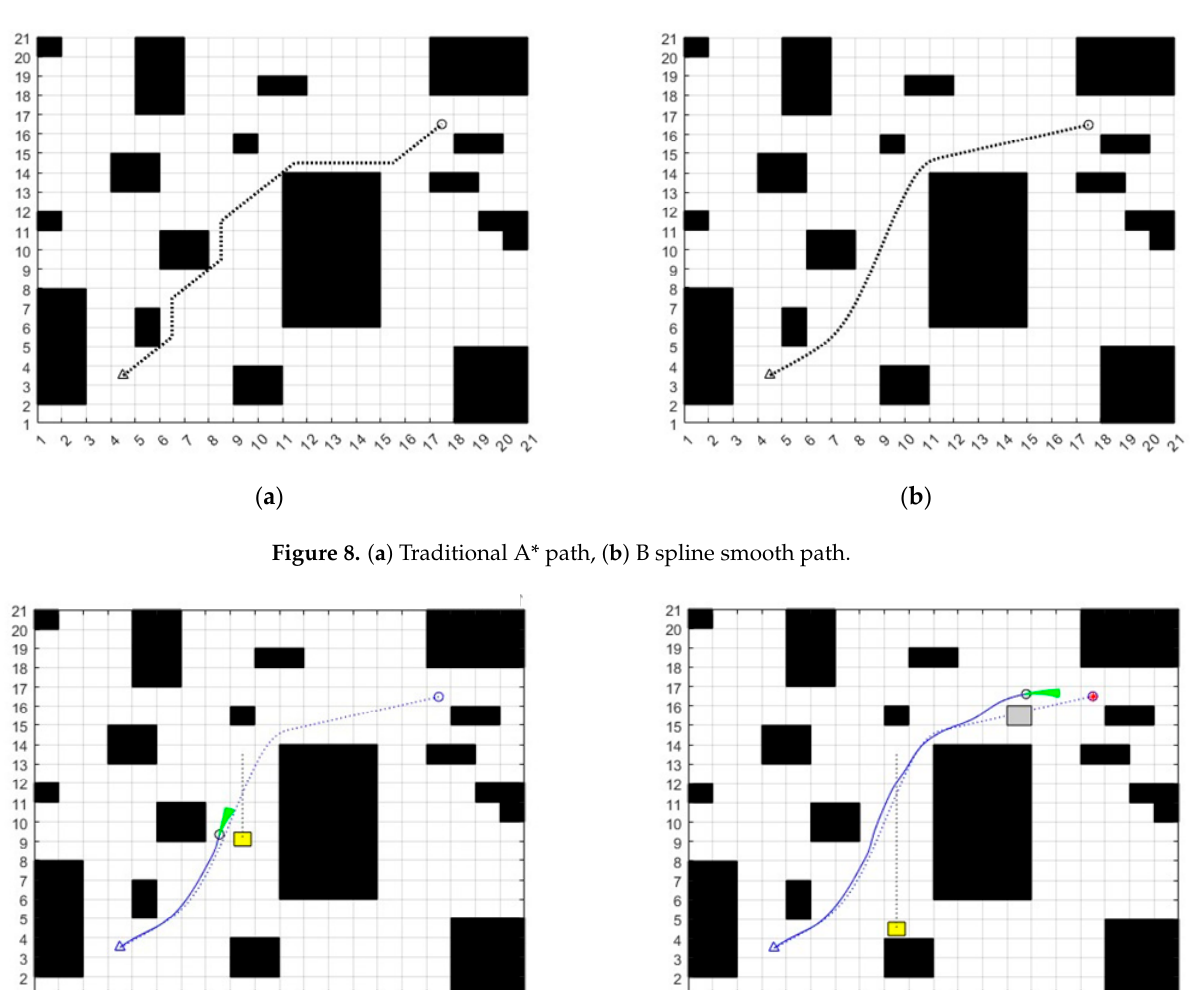
Figure 9. ( a ) Plan path in dynamic obstacle map, ( b ) Plan path in mixed obstacle map. To verify the improved evaluation function of DWA algorithm, the linear velocity,